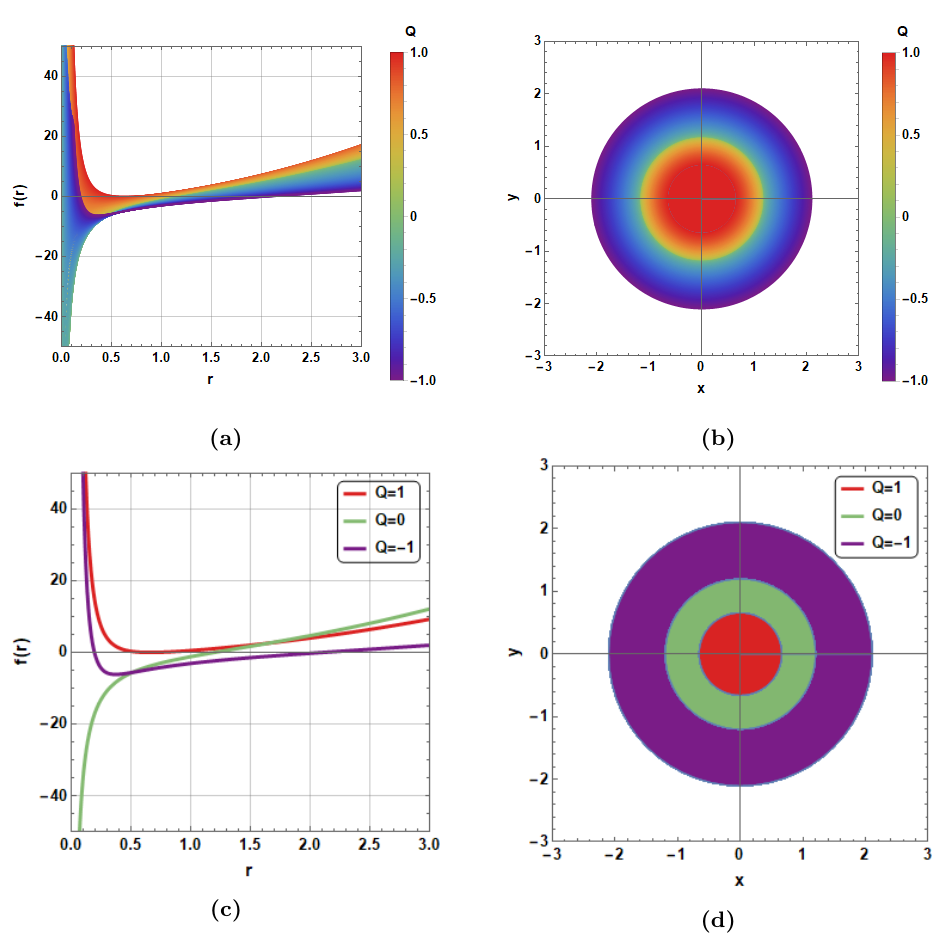
Figure 9. (a) and (c): evolution of f ( r ) function during absorption of 10 3 particles with a fixed electric charge dQ = − 0 . 002 . (b) and (d): evolution of black hole projection on xy plan during absorption of 10 3 particles with a fixed electric charge dQ = − 0 . 002 . The initial conditions are Q = 1 , l = 1 , M = 1 . 23 , r h = 0 . 65 and D = 4